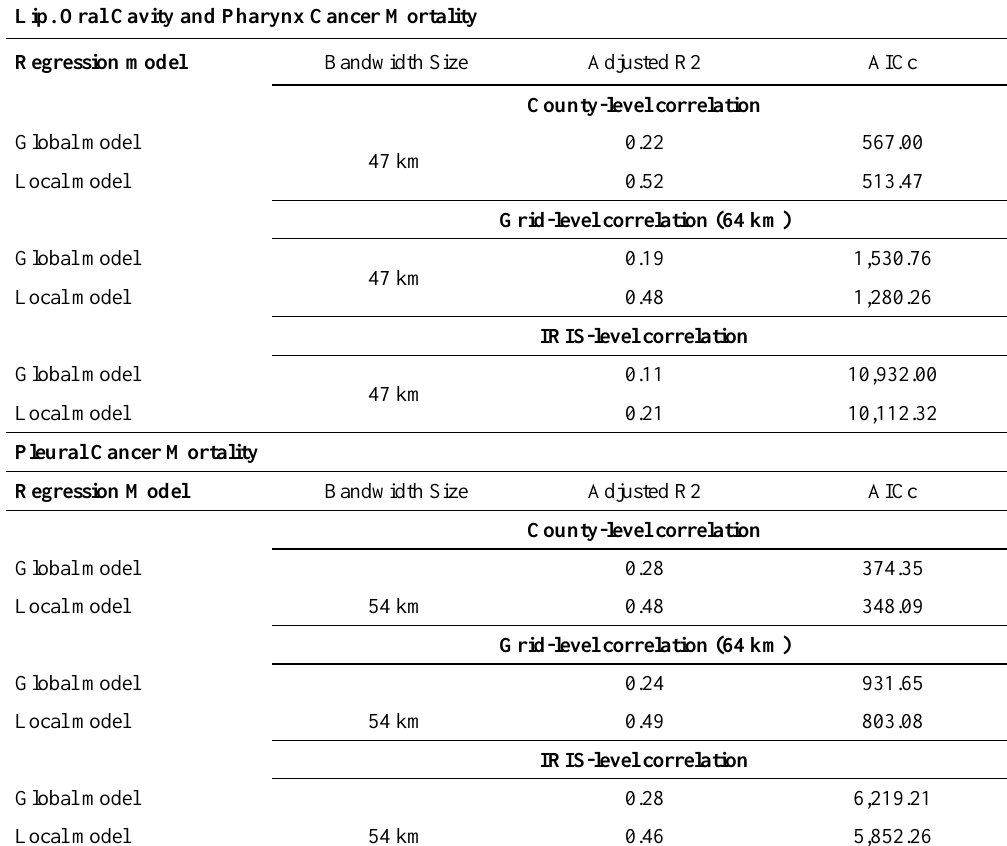
Table 6. Comparison of local and global regression models at the three spatial scales. Lip. Oral Cavity and Pharynx Cancer Mortality